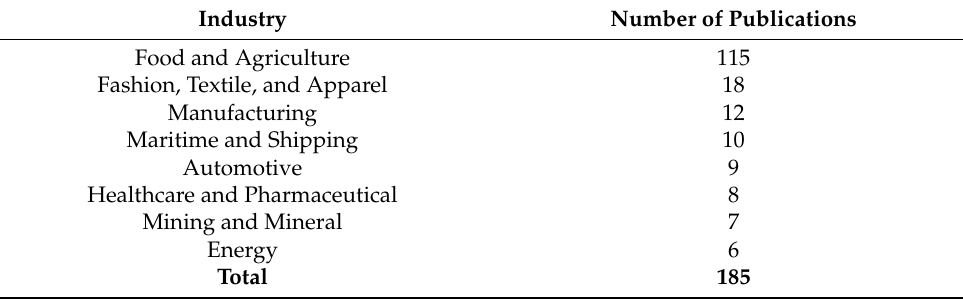
Table 4. Distribution of Publications by